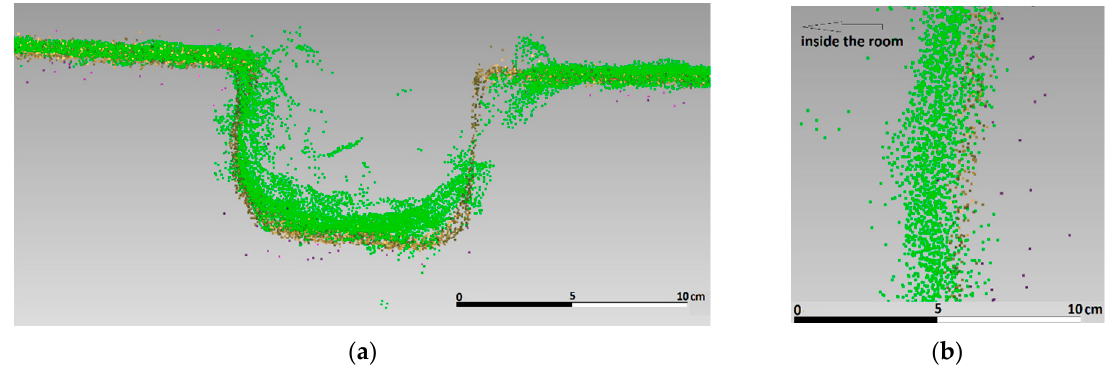
Figure 23. Comparison of joined point clouds from BLK360 (brown color points), Zeb-REVO (purple color points), and close-range photogrammetry (iPhone camera, green color points); ( a ) wooden beam on the ceiling, ( b ) vertical wall in the middle of the synagogue at 1.5 m height.